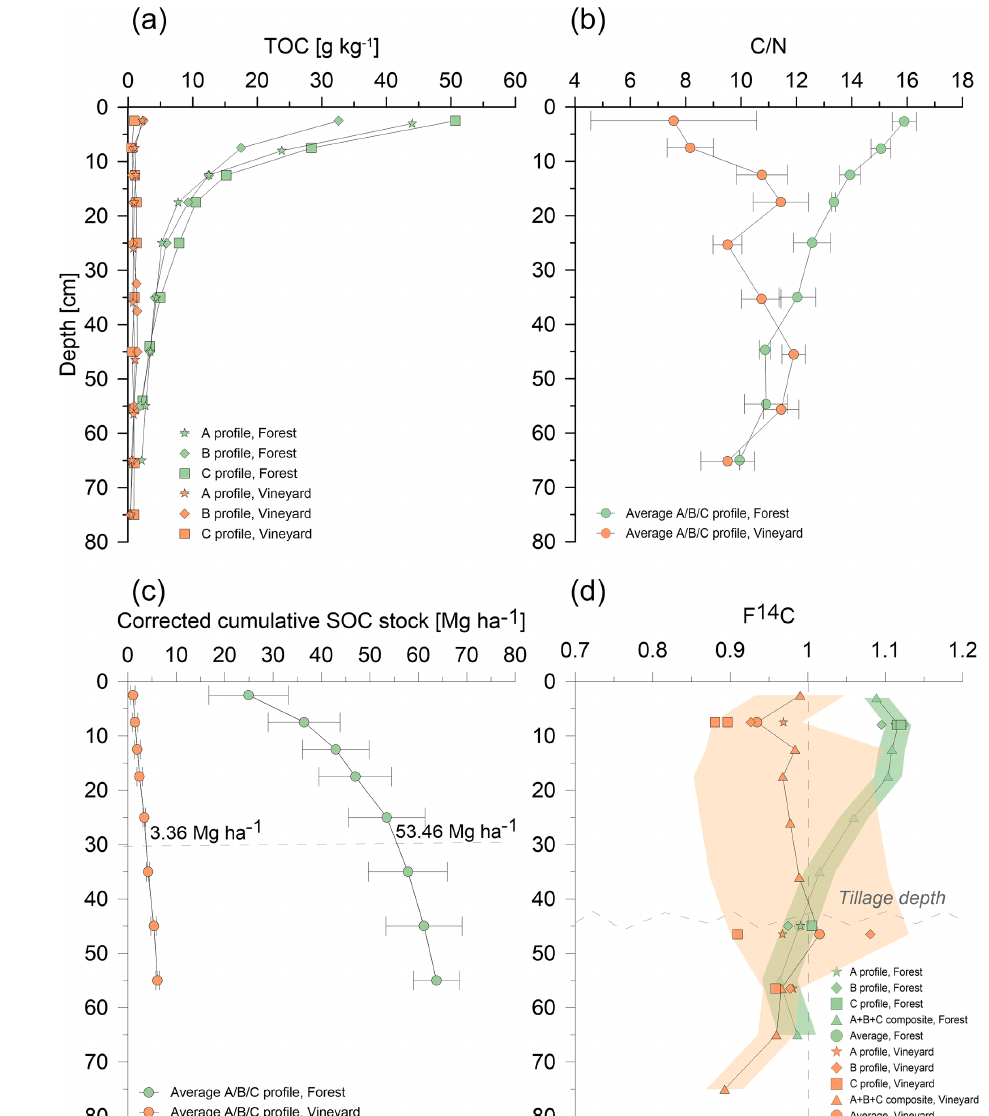
Figure 2. TOC variations (a) , C : N ratio (b) , cumulative stocks corrected for equivalent mass (c) , and F 14 C profiles (d) as a function of depth, under vines (orange) and under forest (green), for an Arenosol under a Mediterranean climate. The corrected cumulative SOC stocks error bar represents the standard deviation. The F 14 C measurement variability (d) is represented by green (forest) and orange (vine)